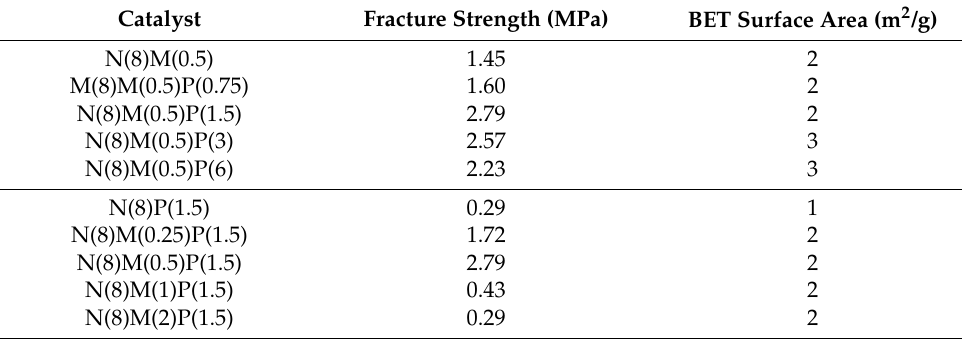
Table 2. Physical properties of catalyst pellets containing MC and P25.